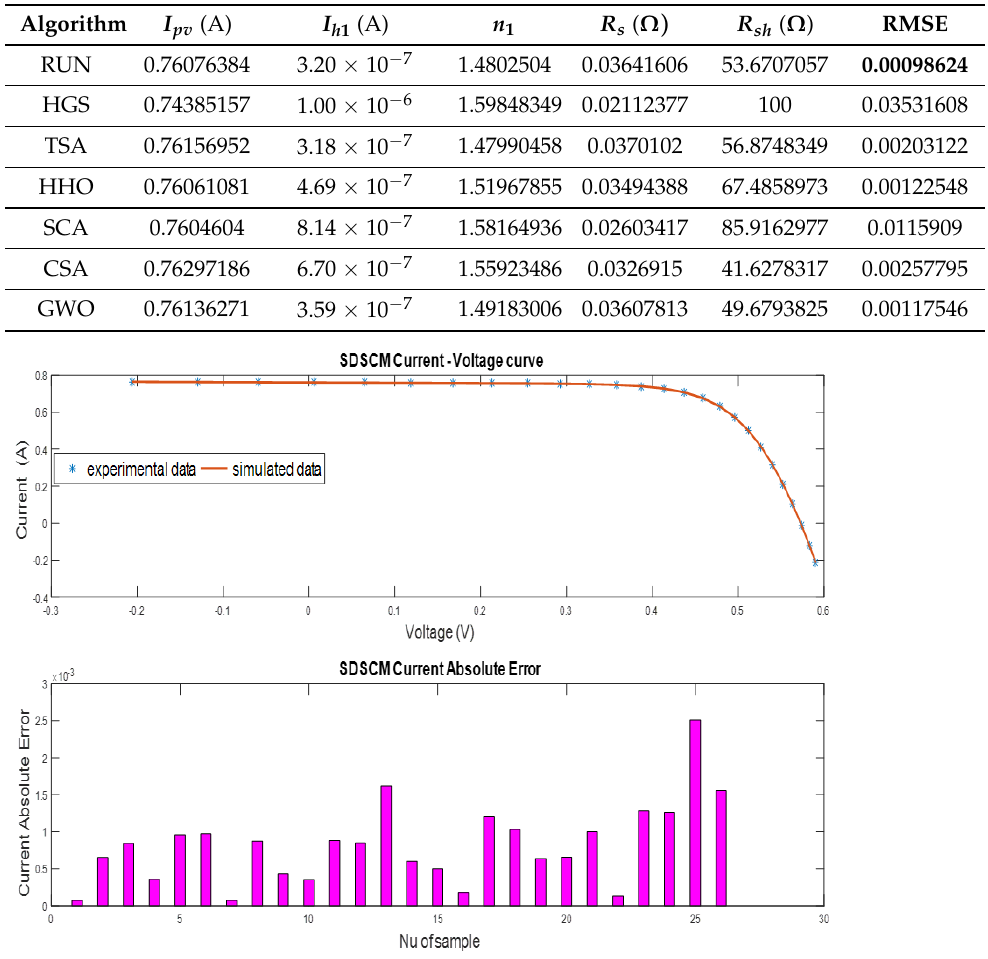
Figure 4. The I-V curve and current absolute error for SDSCM.